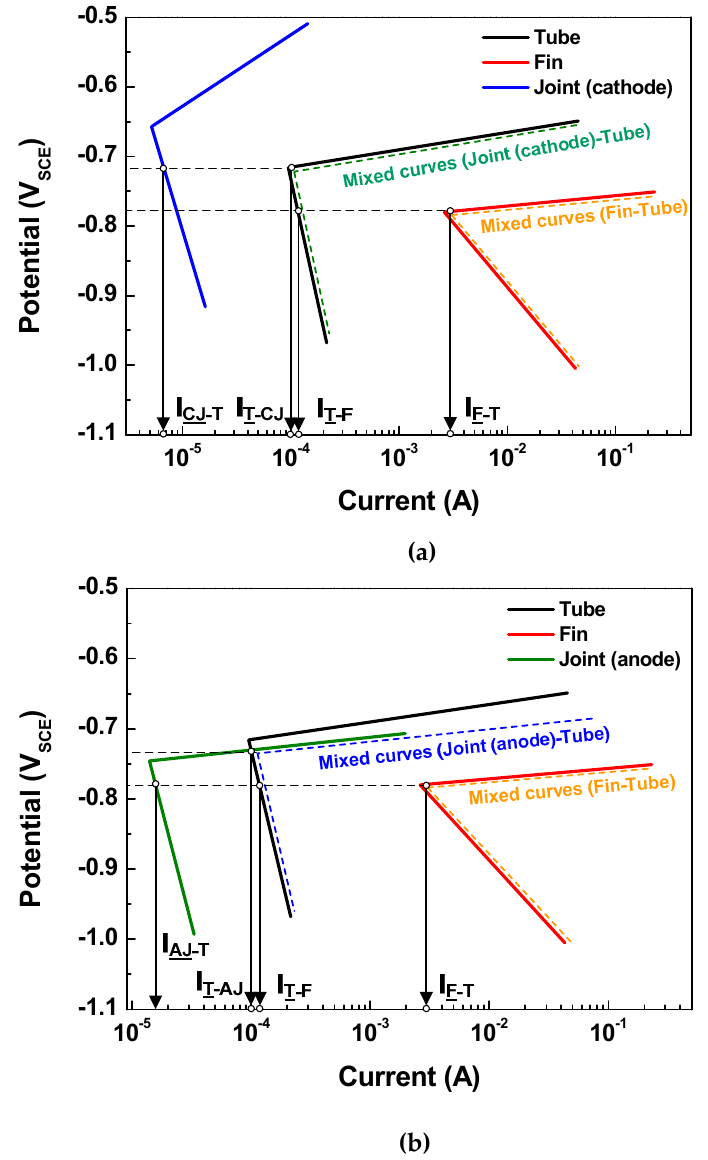
Figure 5. Tafel slopes of the polarization curves applied to the surface areas of the tube, fin, and joint in the 3D model and the calculated galvanic current based on mixed-potential theory: (a) case 1 and (b) case 2.